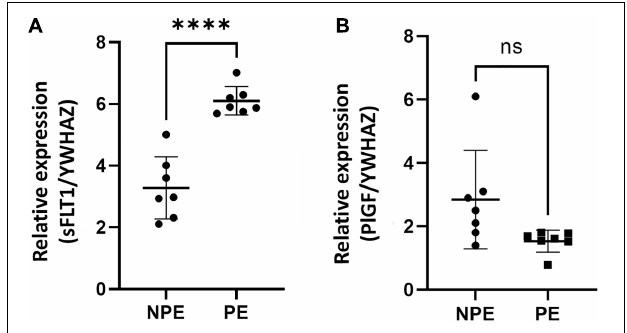
FIGURE 3 | Gene expression of sFlt1 (A) and PlGF (B) vasoactive factors in placental explants cultured with the serum of NPE and PE patients. Gene expression of sFlt1 (A) was higher ( ∗∗∗∗ p < 0.0001) in explants PE serum-treated in comparison with controls (NPE). Data were analyzed using the unpaired Student’s t -test followed by the Mann-Whitney test. The values were represented as mean ± SD; n = 7.